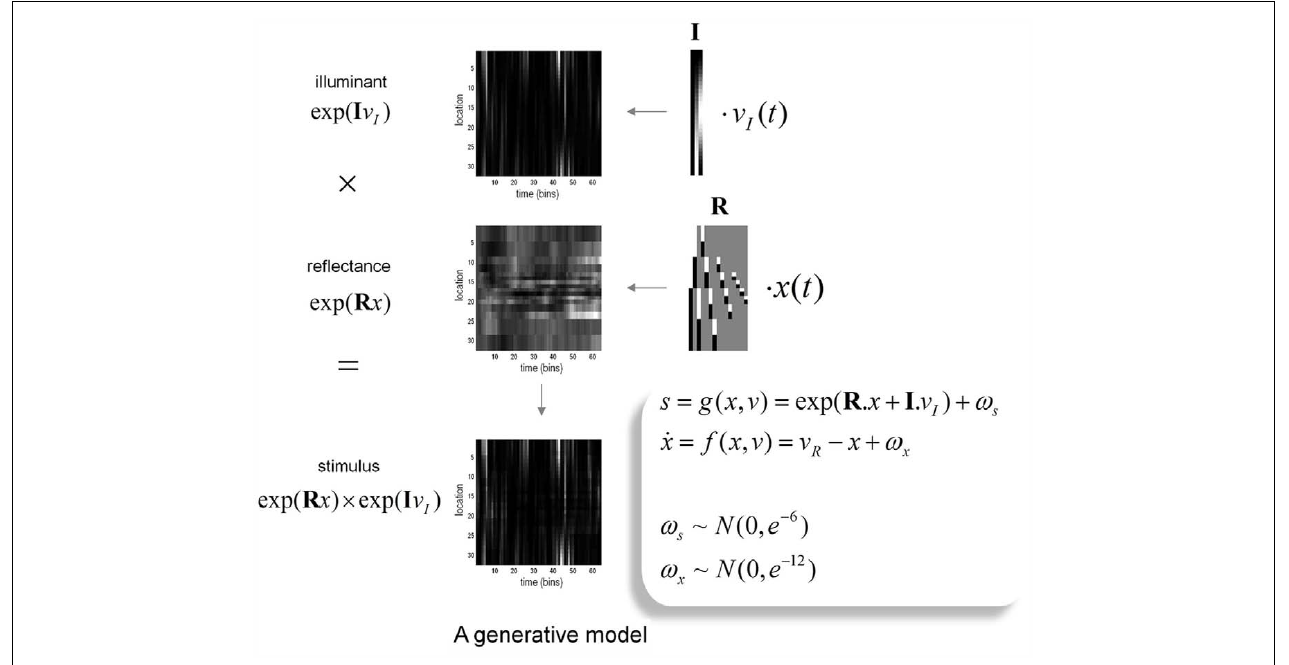
the reflectance basis functions hidden states, which accumulate hidden causes to generate changes in reflectance. Inversion of the model provides conditional estimates of the hidden causes and states responsible for sensory input as a function of time. See main text for an explanation of the variables in this figure.